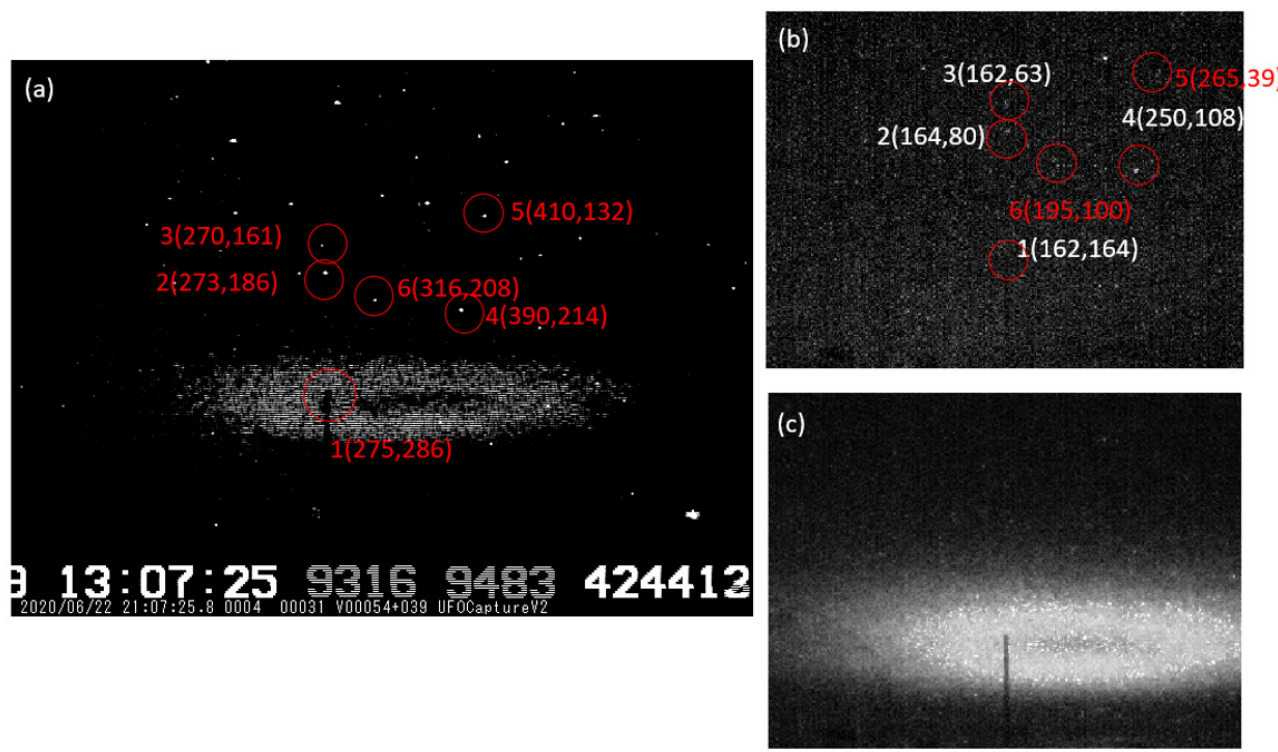
Figure 2. The image processing as an example for coordinate calibration: ( a ) the landscape (antenna tip at the labeled number 1) and star positions at labeled numbers 2–6 in these red circles of the low-light-level CCD recorded image frame, ( b ) the background star field using the overplayed high-speed-camera image by integrating 100 frames without elve emission, and ( c ) the overlapped image by integrating 20 high-speed-camera frames to enhancing the elve emission.